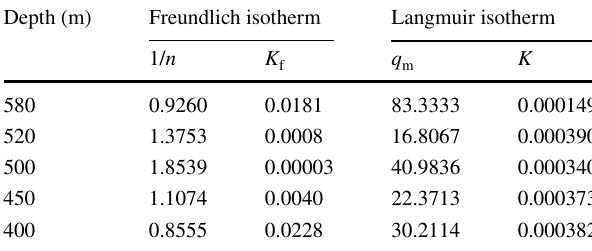
4 sorption isotherm model at 27 °C